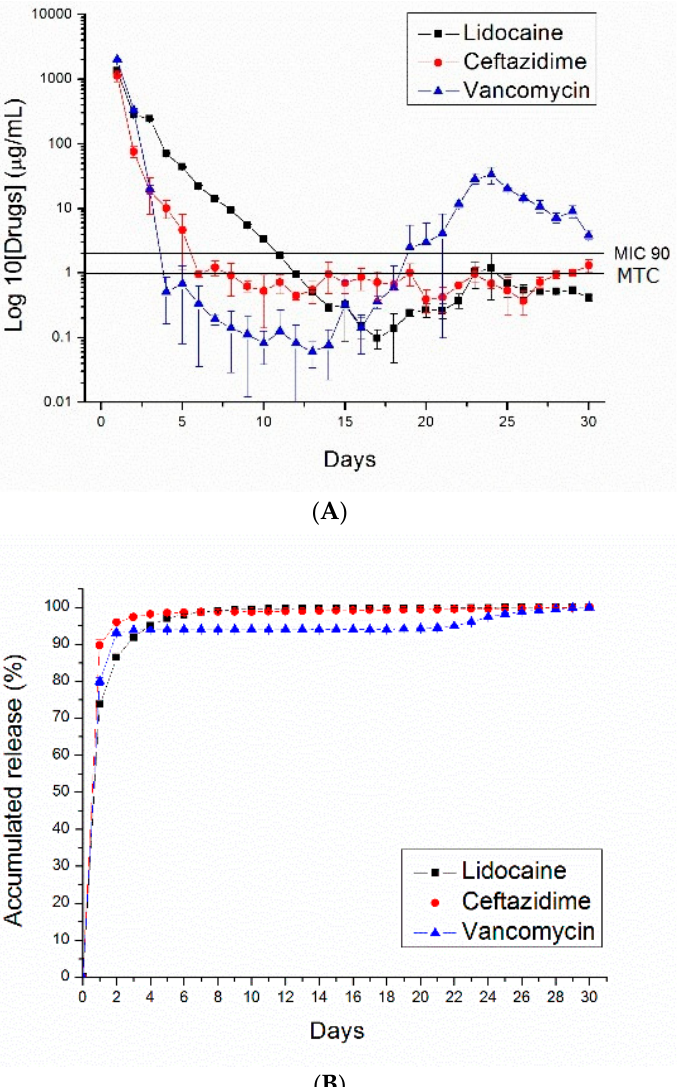
Figure 7. PLGA (50:50)—( A ) daily and ( B ) accumulated release curves of pharmaceuticals from 50 mg PLGA nano/microparticle-loaded buffered solution.